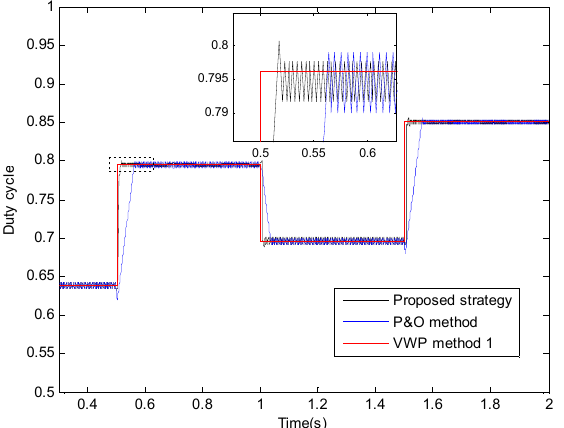
Figure 34. Compared duty cycle curves of the different methods.